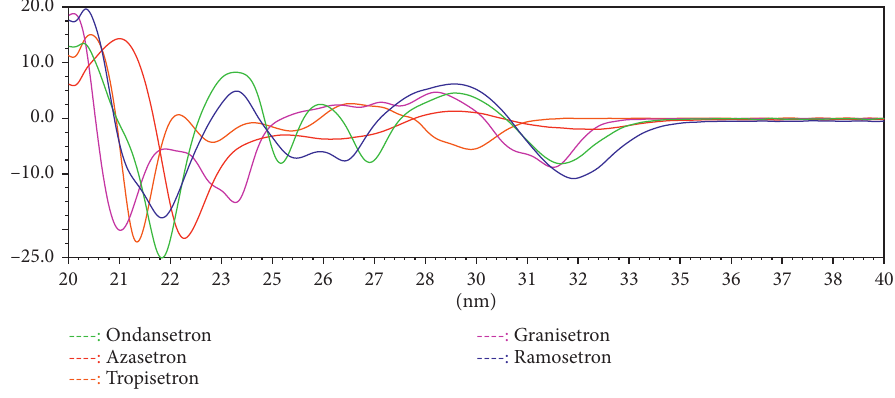
Figure 5: The 1st UV spectra of ODT, GNT, TPT, AZT, and RMT. Table 5: Effects of instrument, column, flow rate, pH value of mobile phase, and column temperature upon RRTof the five 5-HT antagonists.